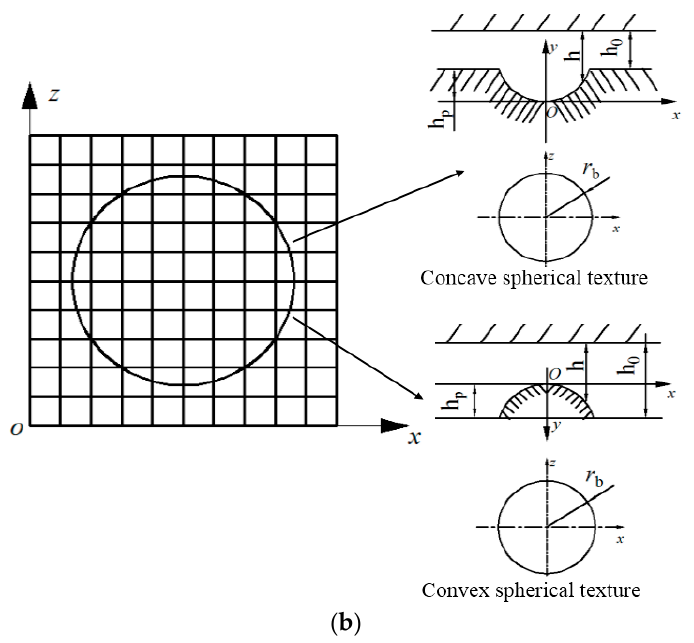
Figure 2. Journal bearing model with spherical texture: ( a ) schematic of the bearing model and ( b ) grid details of different textures.